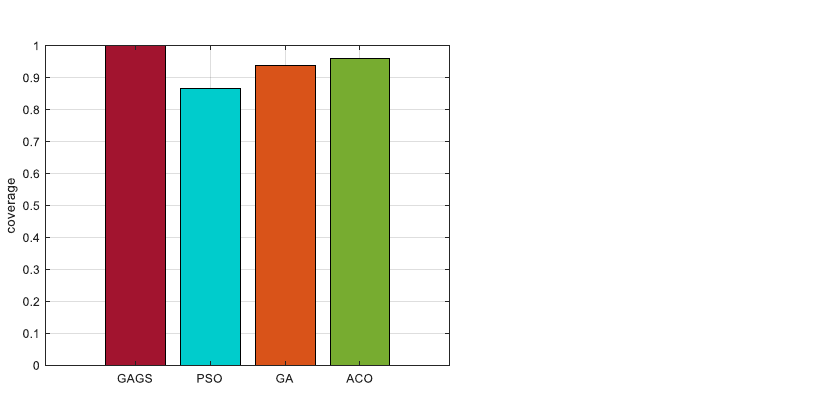
Figure 11. Node deployment after increasing the coverage model attenuation factor. Since the increase of the attenuation factors α , β will accelerate the attenuation speed of the coverage rate of the perception model, the effective coverage area of each node will be relatively reduced, leading to an increase in the number of WSN nodes to achieve full coverage of the area. The deployment coverage of each algorithm can be seen in Figure 12.